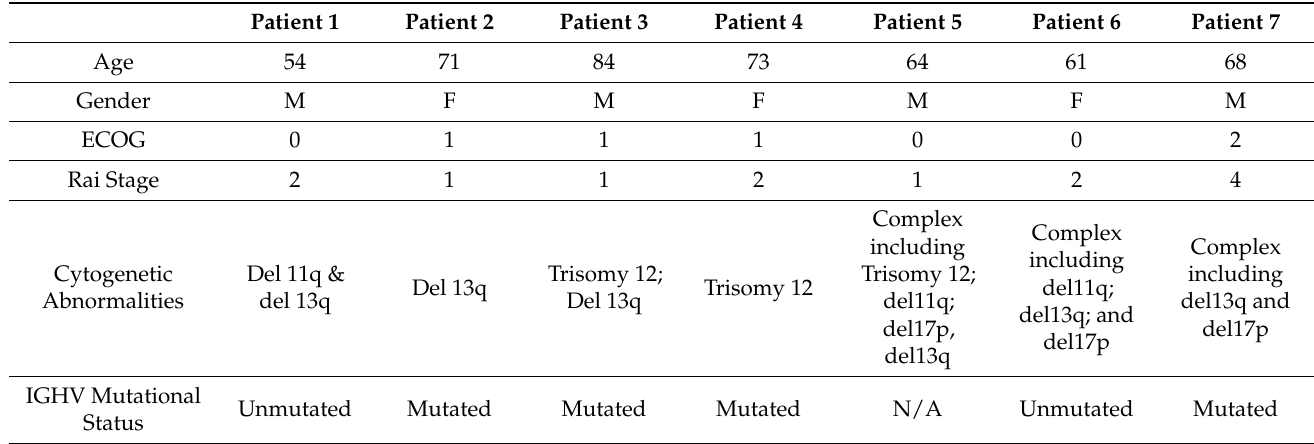
Table 2. Patient